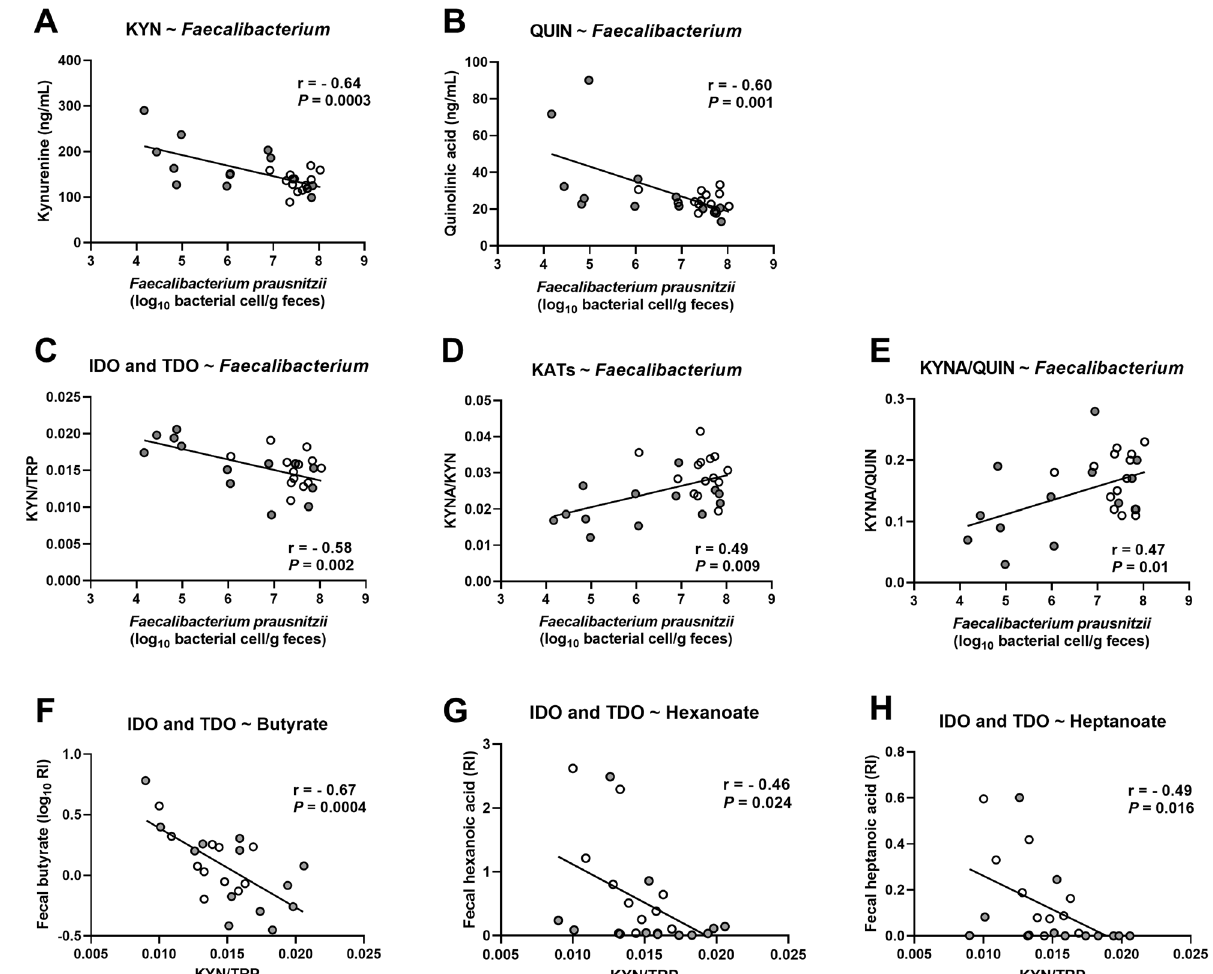
Fig. 5 Correlations between tryptophan metabolites, intestinal bacteria and bacterial metabolites. Correlations between the levels of F. prausnitzii measured by qPCR and the metabolites ( A ) KYN, ( B ) QUIN and with the metabolic ratio re fl ecting ( C ) IDO and TDO activities, ( D ) KATs activity and ( E ) the balance between neuroprotective and neurotoxic metabolites. F – H Correlations between the fecal levels of short- chain- and medium-chain fatty acids and the KYN-to-TRP ratio re fl ecting IDO and TDO activities. The correlations were calculated in healthy controls (white circles) and in AUD patients (gray circles) at the end of the detoxi fi cation program (T2) using Pearson ’ r coef fi cient, n = 24 –